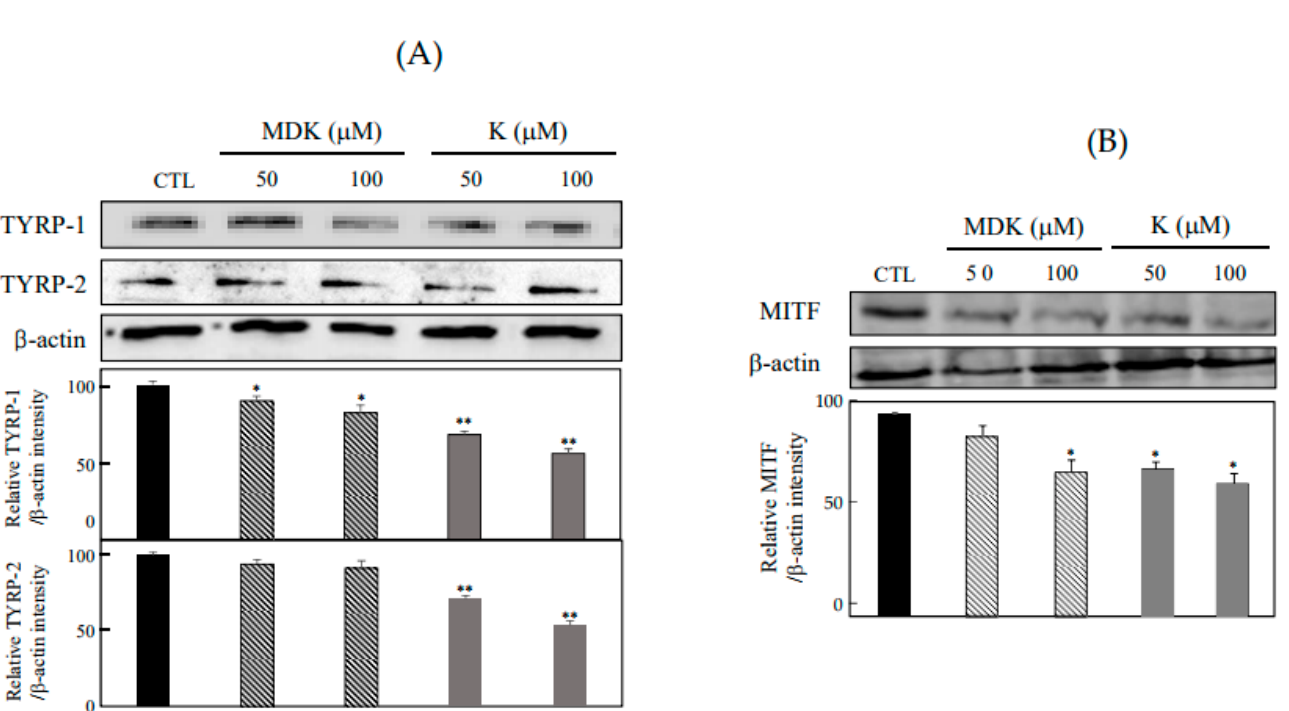
Figure 6. Effects of K and MDK on TYRP-1, TYRP-2 and MITF expression. The density graph represents the relative band density for TYRP-1, TYRP-2 ( A ) and MITF ( B ) normalized to β -actin. The data are represented as the mean ± SD (n = 3) of three individual experiments. * p < 0.05 and ** p < 0.01 compared with control.